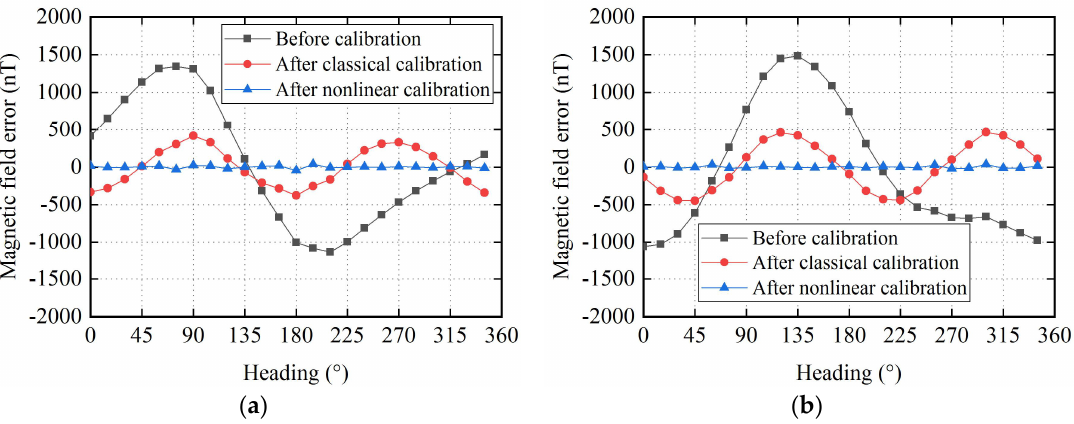
Figure 5. Errors of the magnetic field component for each axis before and after calibration: ( a ) x -axis; ( b ) y -axis. Sensors 2018 , 18 , x FOR PEER REVIEW